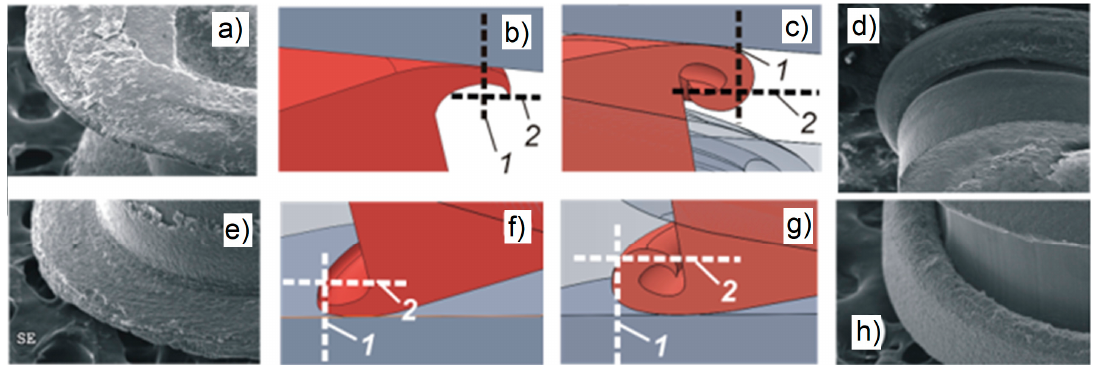
Figure 14 . The course of the UOM process depending on the shape of die-cavity: ( a ) and ( b ) The theoretical course of the process without the impact of die-cavity; ( c )–( h ) The influence of vertical, 1, and horizontal, 2, limits.